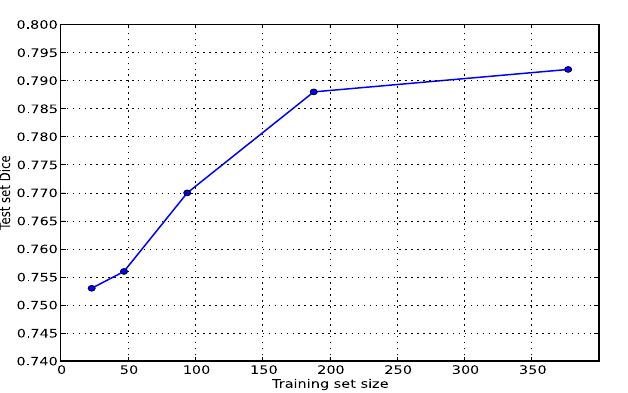
Figure 5. Test Dice as a function of training set